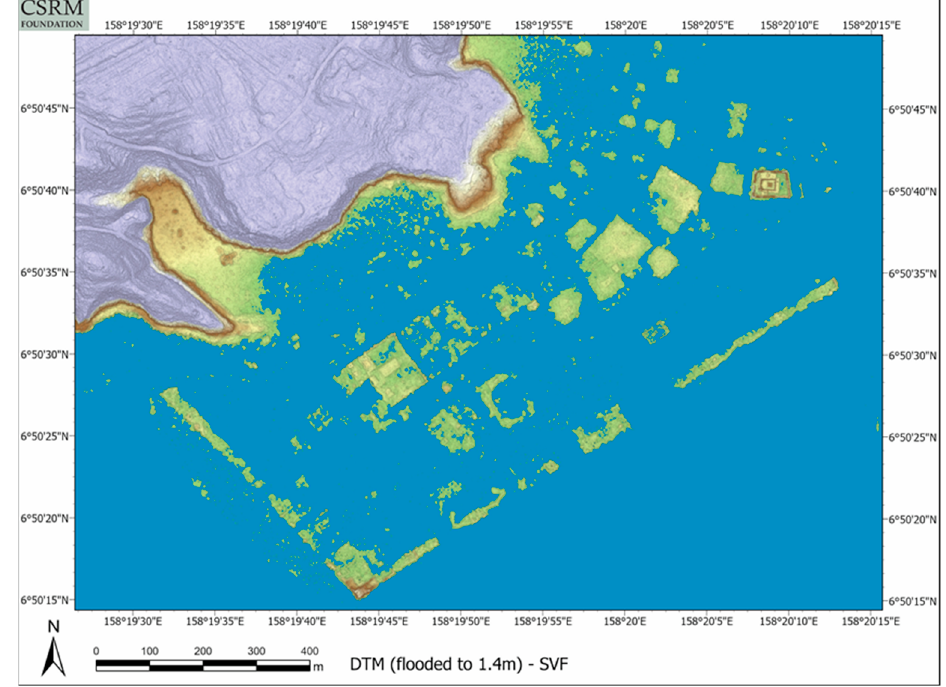
Figure 8. An inundation ‐ simulation model: A DTM visually flooded to 1.4 meters on SVF with 5.0 vertical exaggeration.